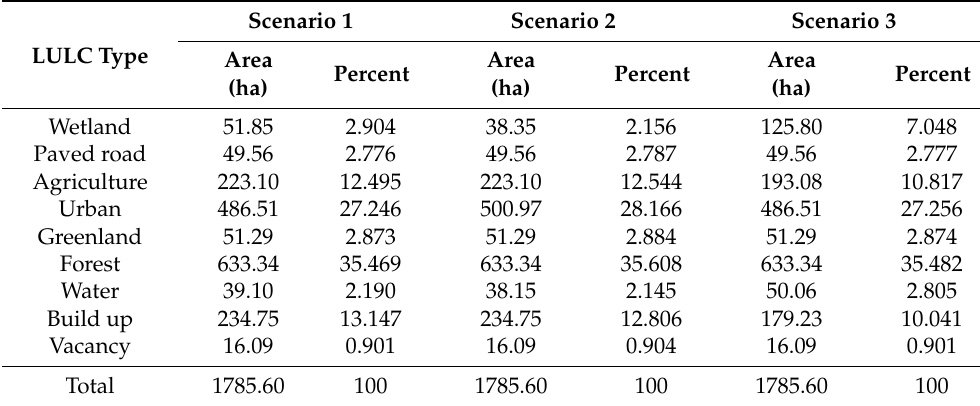
Table 4. The percentage of Mangrove Park about LULC data in the three